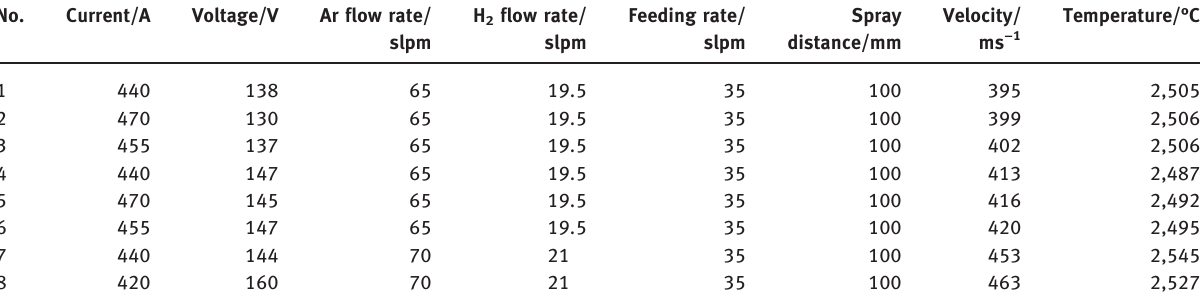
Table 1: The process parameters in SAPS. No.